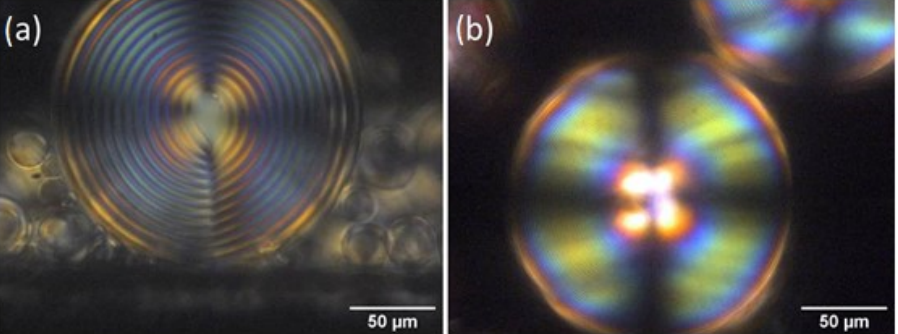
Figure 9. Polarized-light optical microscopy image of a microsphere of: ( a ) oxazine-doped DSCG + L-alanine; and ( b ) oxazine-doped DSCG + Trans-Hyp. Comparing data from the two flexible films (Figure 10), the half-pitch observed in microspheres containing DSCG doped with L-alanine had an average value of 5.83 ± 0.05 μm, whereas in the sample with Trans-Hyp, a half-pitch of 1.74 ± 0.05 μm was measured. These values are comparable with the ones measured in emulsions.